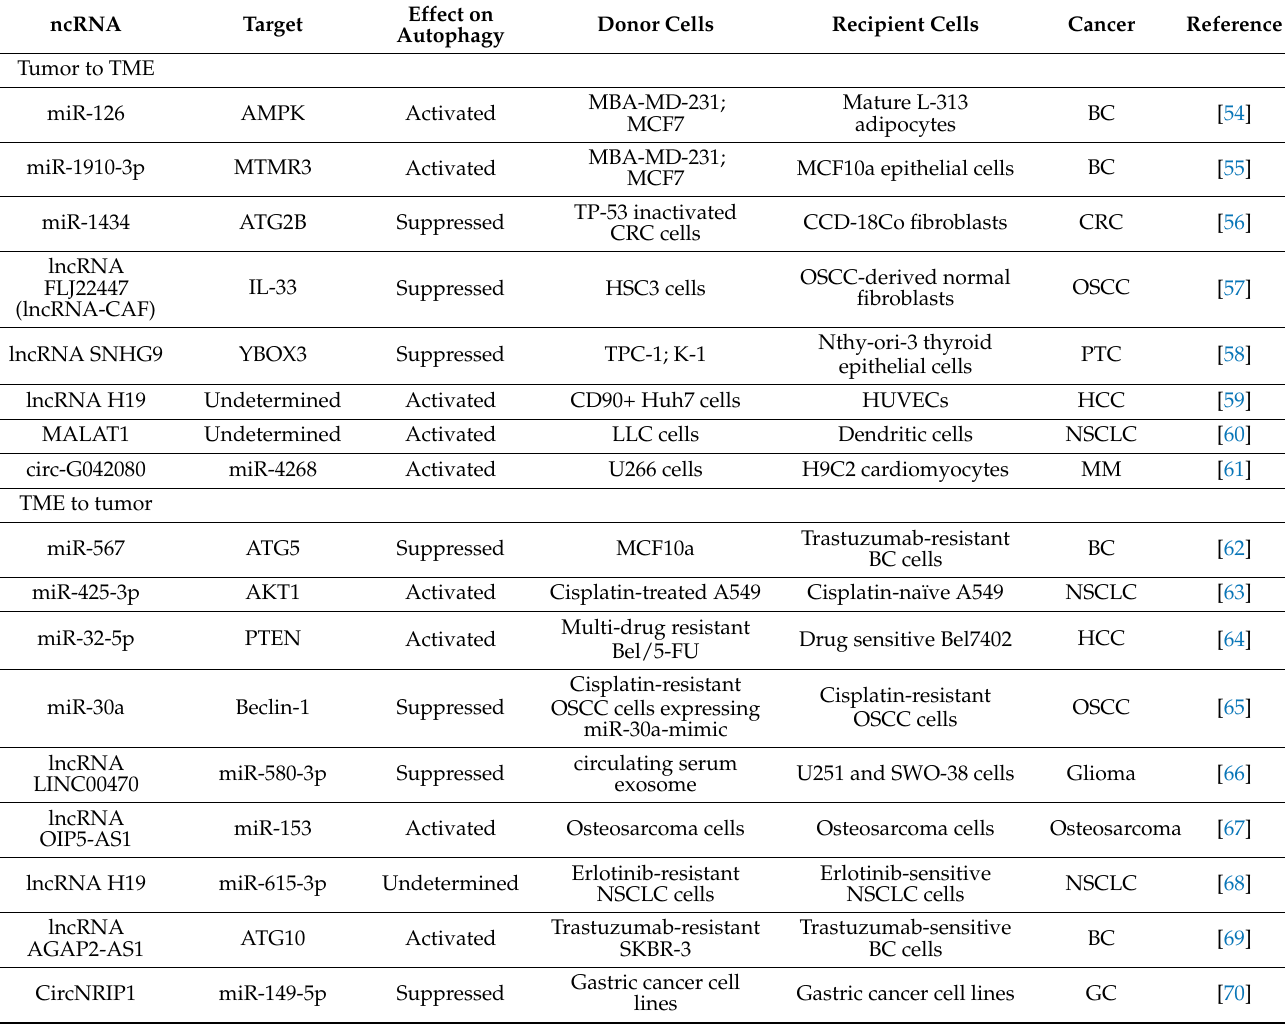
Table 1. Exosomal ncRNAs modulating autophagy in tumor–TME